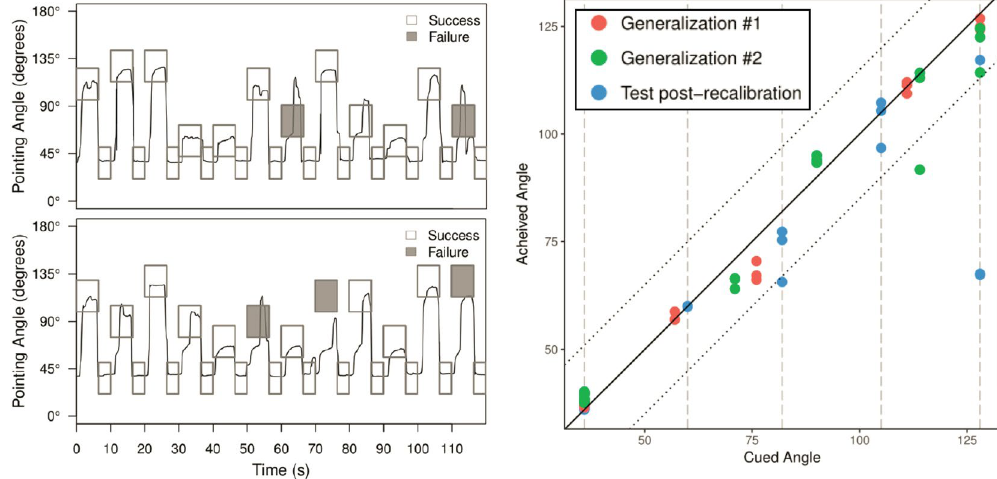
Figure 5. (Left) Participant generates force to match angles that were not used during training in Generalization Blocks 1 (top left) and 2 (bottom left). For these two blocks, the three middle angles were moved to positions the participant had never attempted before. The participant was successful on 22 of 24 cues for the first generalization block and 21 of 24 for generalization block 2. In both blocks, he was successful on 7 of the 9 cues for new angles. (Right) For each cue in the generalization blocks as well as Test Block 4 (post-recalibration) the 2 s where the average achieved angle was closest to the cued angles was extracted and the average achieved angle over that 2 s is plotted against the cued angle. The colors denote the different blocks. The diagonal black line indicates the line of perfect performance where the achieved angle is exactly the cued angle; the upper and lower dotted black lines show the 15° tolerance bands around the middle line. The vertical dashed lines indicate angles used for the Training and Test Blocks 1-4. The plot demonstrates that the participant was not only in the tolerance window during the generalization blocks but also could point to the new angles with similar precision to the angles used during